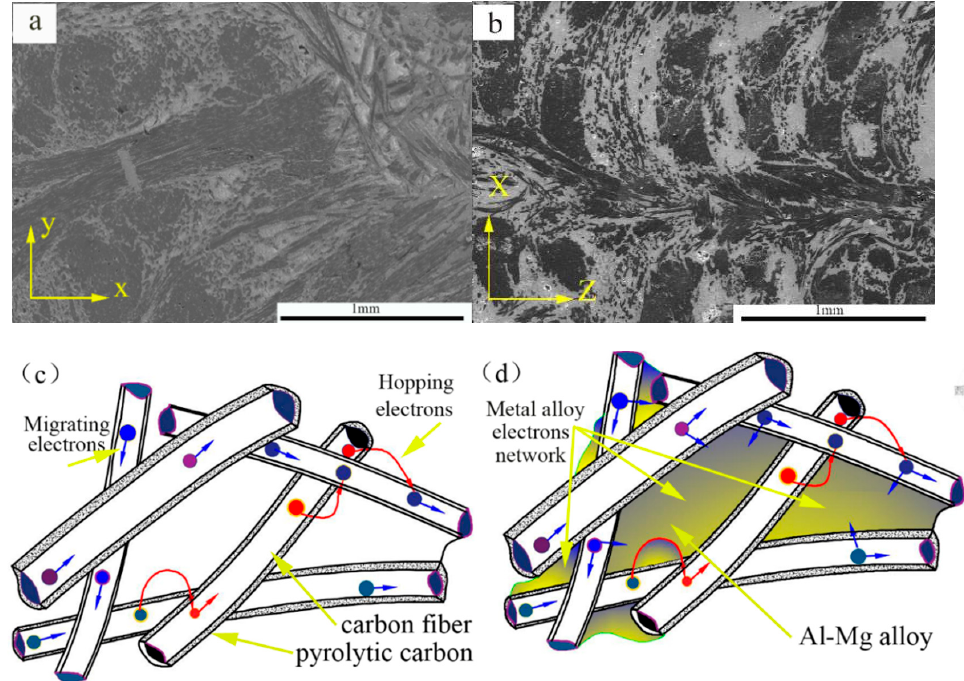
Figure 9. Microstructure and conduction mechanisms of C/C–Al–Mg. ( a , b ) SEM micrographs of C/C–Al–Mg and a schematic diagram of the conduction mechanism; ( c ) Initial conditions; ( d ) Impregnation metal conditions.